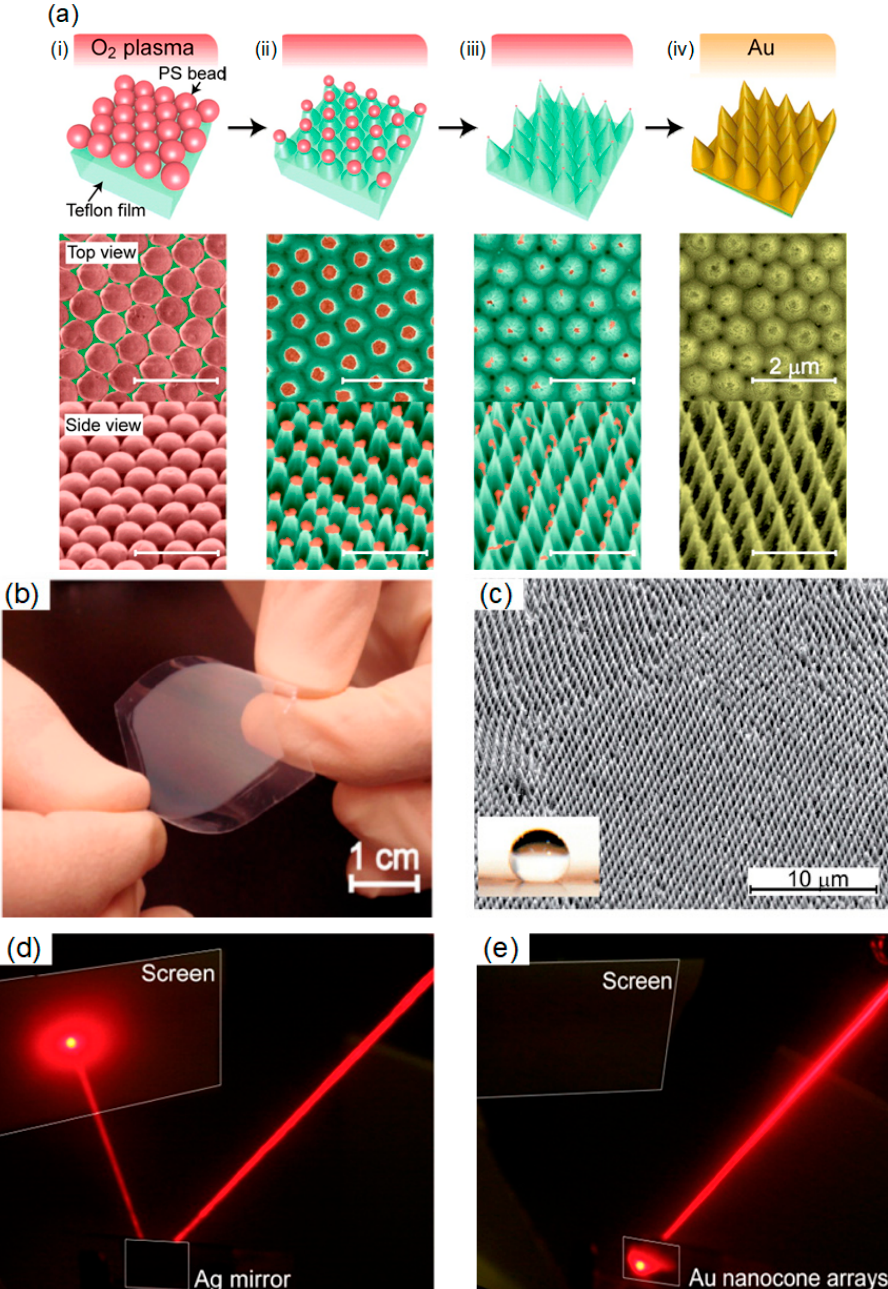
Figure 5. ( a ) Top row: schematic illustration of the fabrication process (top row): ( i ) Fabrication of a PS bead monolayer on a flexible Teflon film; ( ii , iii ) Formation of nanocone arrays by simultaneous plasma etching PS beads and Teflon film; ( iv ) Deposition of gold thin film on the Teflon nanocone array. Colored SEM images of the corresponding samples in both the top (middle row) and tilted (bottom row) views. The scale bar is 2 µ m in all the SEM images. ( b ) Photographs of nanocone arrays on the Teflon film. ( c ) SEM image of the gold nanocone array in tilted view. Photographs showing the laser beam path reflected by ( d ) a silver mirror and ( e ) a gold nanocone array. Reproduced from [80] with permission; Copyright ACS 2013. Reproduced from [81] with permission; Copyright ACS 2014.